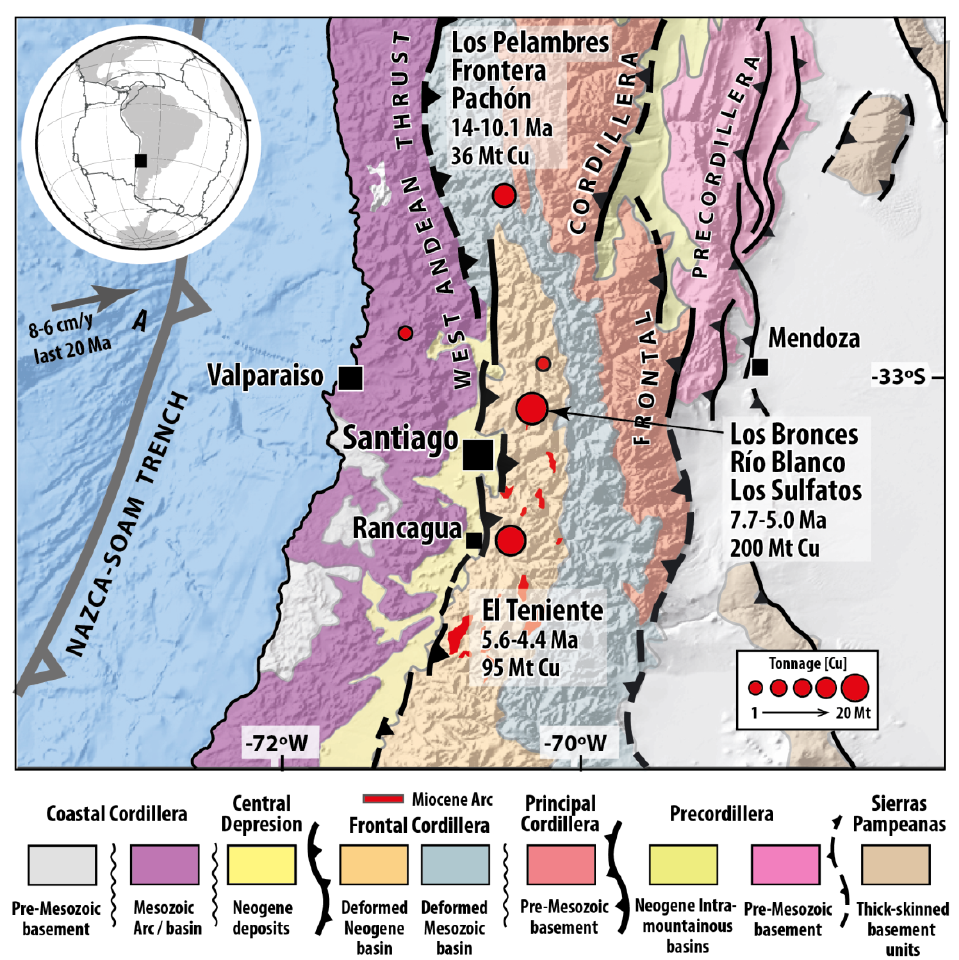
Figure 1. Physiography and first-order tectonic setting of the Central Andes showing the geological framework of the Río Blanco–Los Bronces–Los Sulfatos Cu-Mo porphyry system (modified from reference